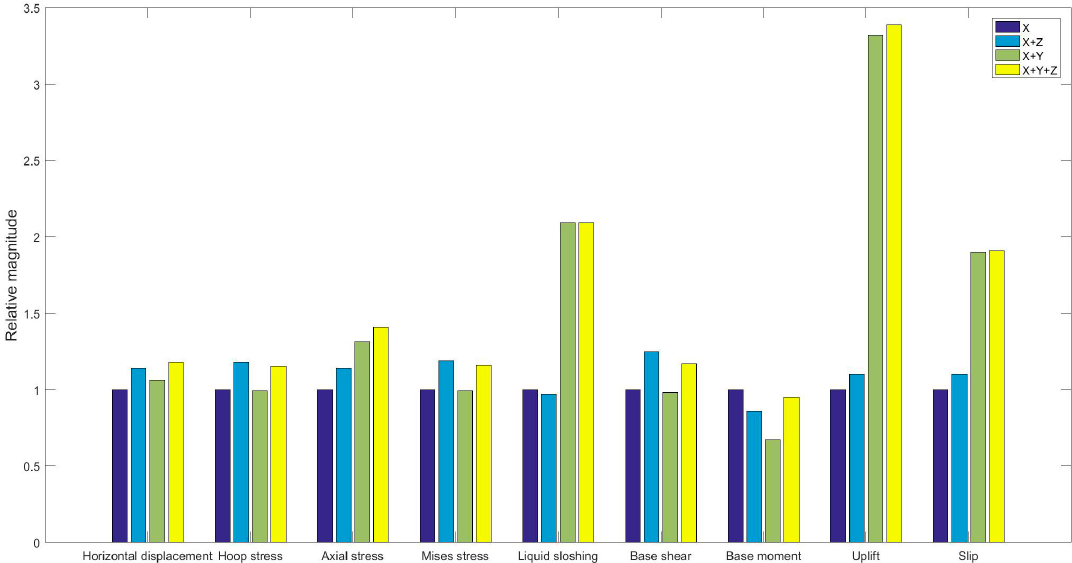
Figure 6. Comparison of the peak normalization of the seismic response of the tank under El Centro ground motion.